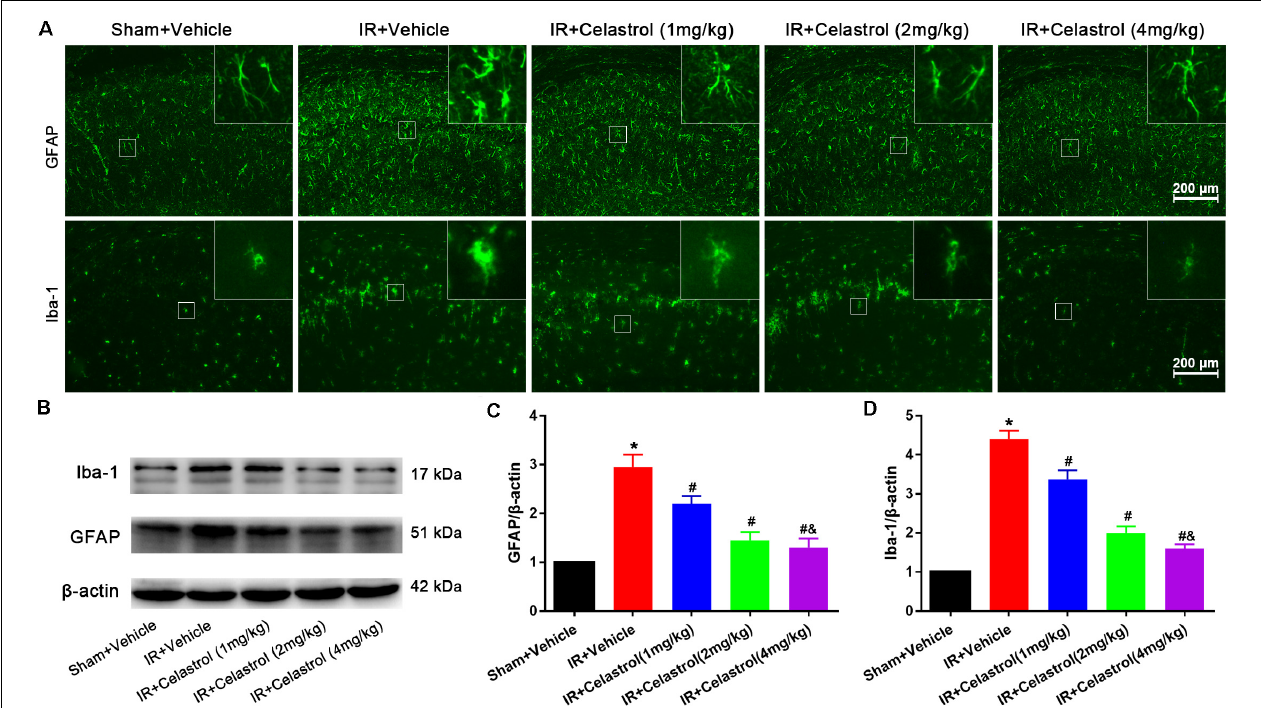
FIGURE 3 | Celastrol attenuates glial activation in the hippocampus. (A) Examples of immunofluorescent images of GFAP and Iba-1 staining in rat hippocampus 3 days after tGCI/R, the built-in thumbnails in the upper right corner show the morphological changes of astrocytes and microglia. Data were obtained from 4 independent animals, and the results of a typical experiment are presented. Scale bar = 200 µ m. (B–D) Representative western-blot images and quantitative analysis of GFAP and Iba-1 in the hippocampus 3 days after tGCI/R. The error bars represent mean ± SEM ( n = 4, * P < 0.05 vs. Sham + Vehicle group; # P < 0.05 vs. IR+ Vehicle group; & P < 0.05 vs. IR + Celastrol (1 mg/kg) group; δ P < 0.05 vs. IR + Celastrol (2 mg/kg)